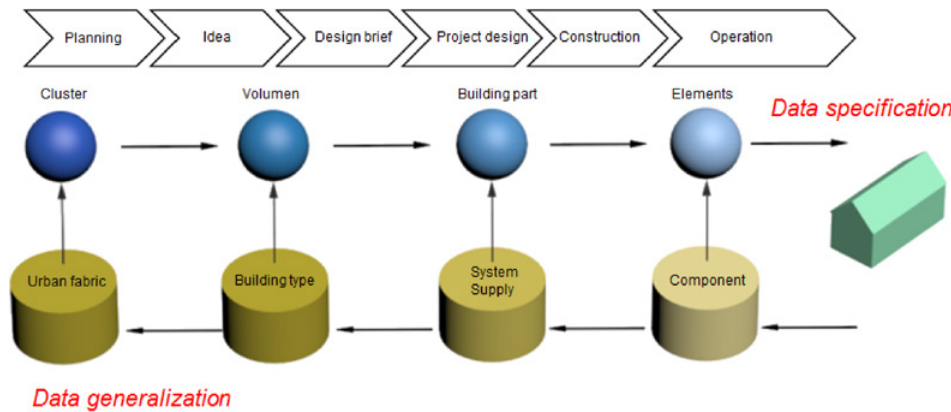
Figure 7 Framework for data specification and data